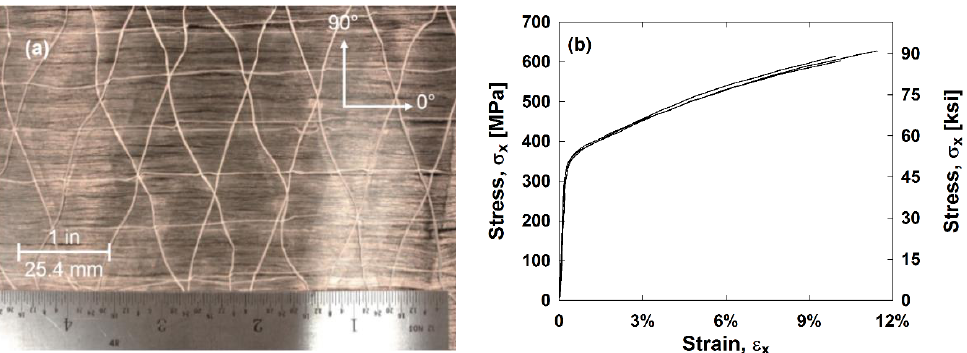
Figure 1. ( a ) Steel reinforcement fibers and ( b ) single stainless steel fiber stress – strain relationships. Fiberglass Reinforcement